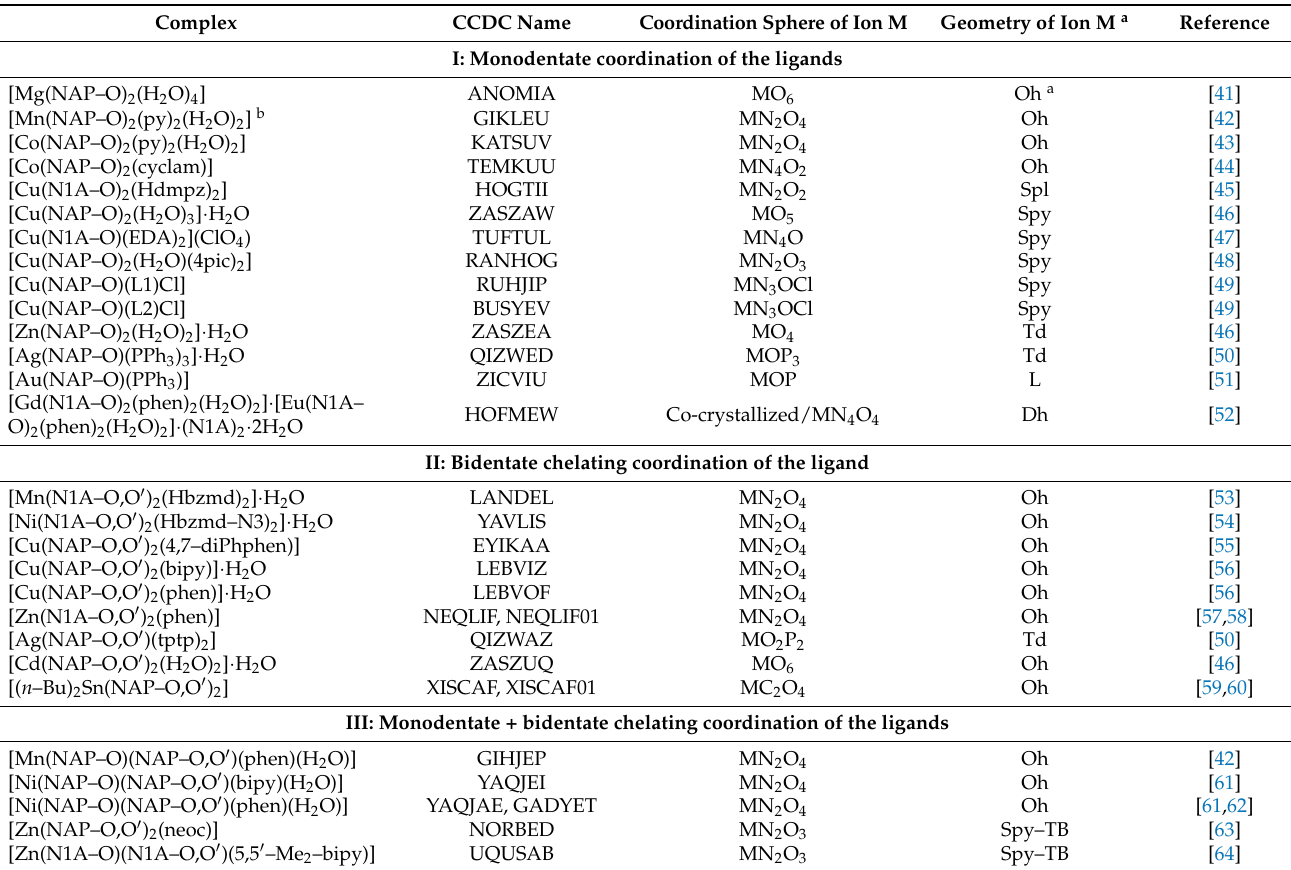
Coordination mode of the ligands, CCDC name of the complex, coordination sphere and geometry of the metal